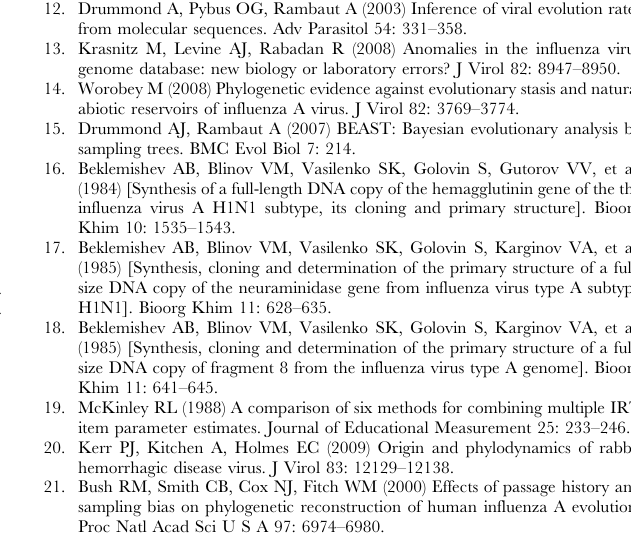
Table S8 Bayes factor model test on PB2 segment.